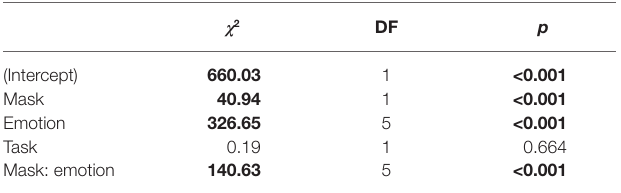
TABLE 1 | Omnibus test for effects of mask, emotion, and task on emotion recognition accuracy.